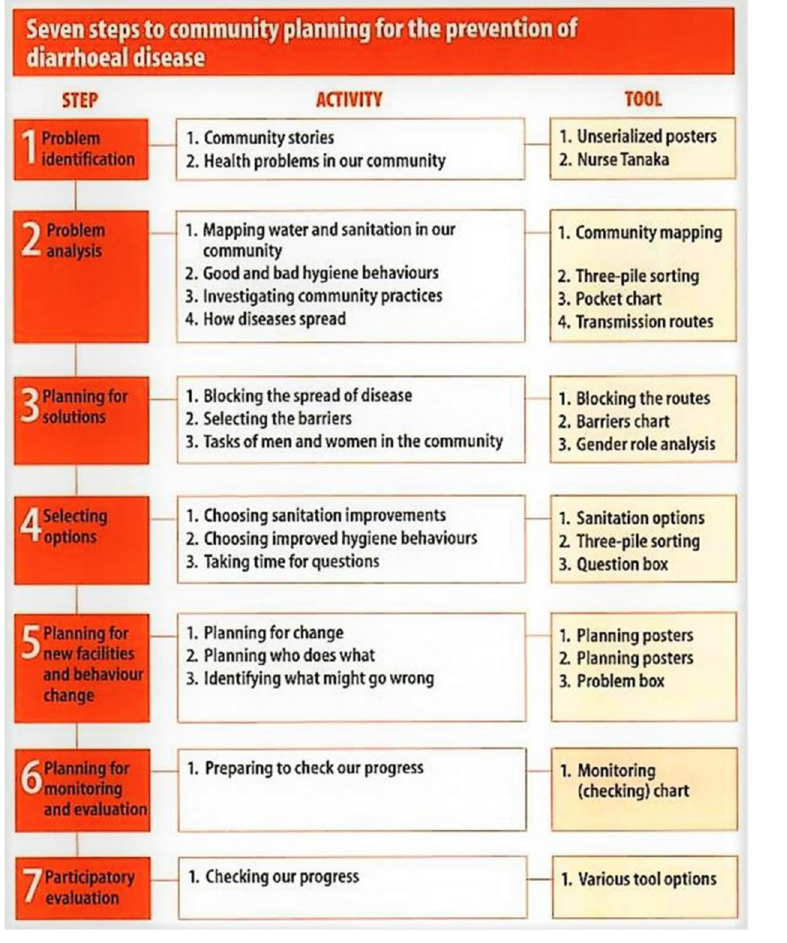
Fig 4. The PHAST framework for community planning to prevent diarrheal diseases